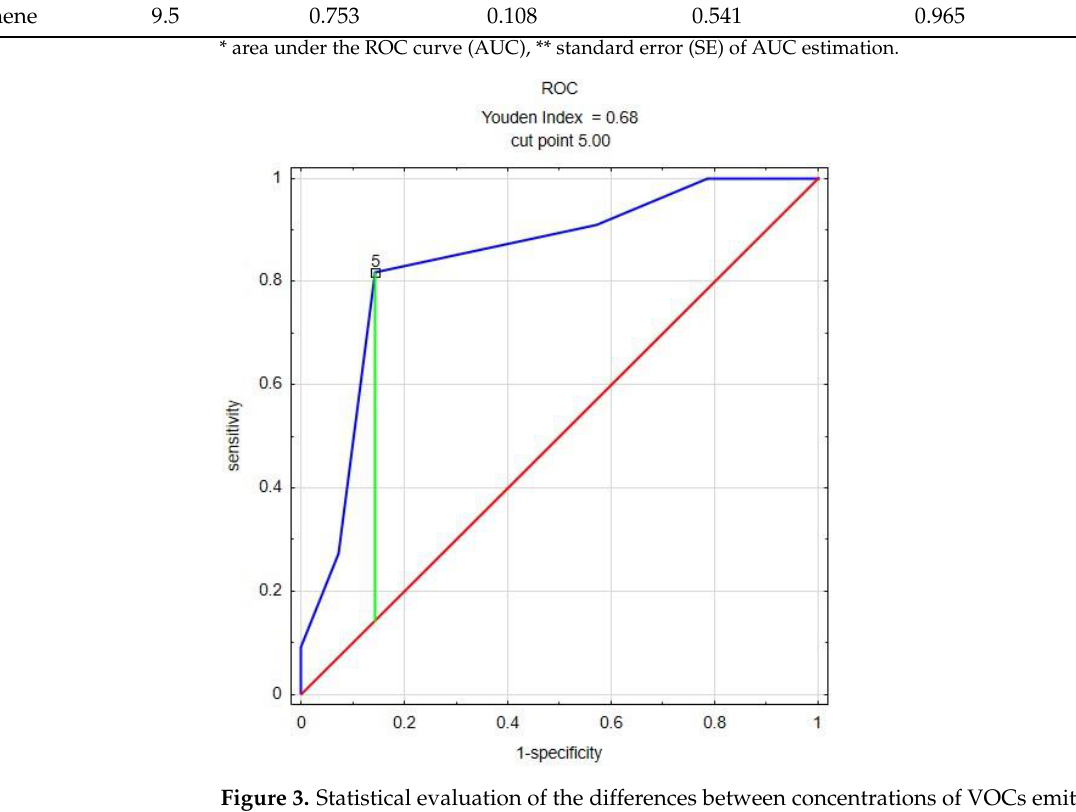
Figure 3. Statistical evaluation of the differences between concentrations of VOCs emitted by brood taken from healthy and infected with P. larvae colonies. ROC analysis. Number of VOCs in brood. Green line: change in sensitivity, blue line: change in specificity, red line: division of a square for field counting.